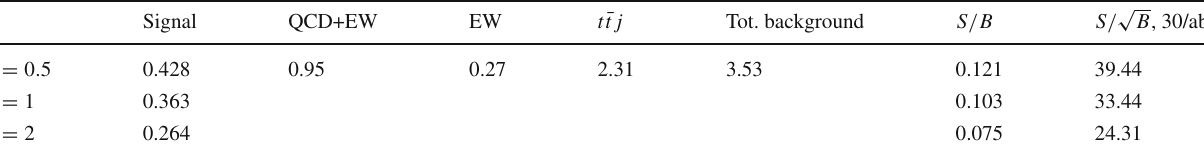
threedifferentchoicesoftheself-couplingwithinthe κ framework[64], κ λ = λ/λ λ = λ SM ; BDT training is performed with SM .